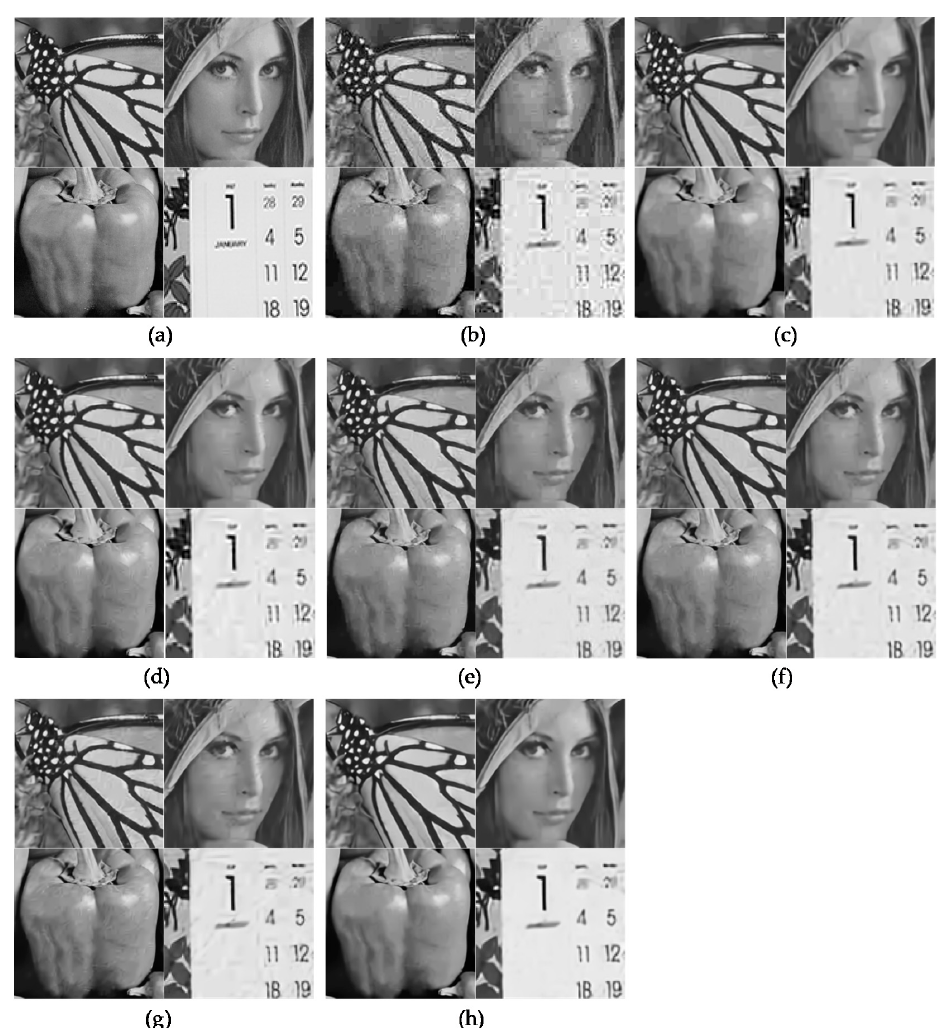
Figure 6. Comparison of the subjective visual quality for four classical images: Butterfly, Lena, Peppers, and Mobile. ( a ) Ground truths. ( b ) Degraded images with q = 10 and peak = 200. ( c ). Results of BM3D [22]. ( d ) Results of SSRQC [23]. ( e ) Results of ARCNN [2]. ( f ) Results of DnCNN [4]. ( g ) Results of MWCNN [5]. ( h ) Results of SCENet.